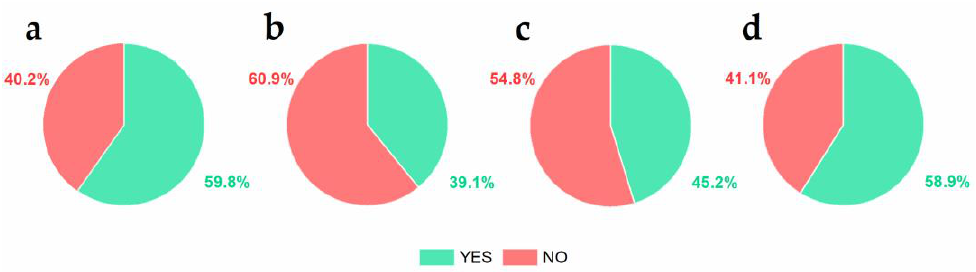
Figure 4. Share of people considering the environmental impact when selecting building materials in the surveyed groups: ( a ) investors, ( b ) architects, ( c ) contractors, ( d ) sellers of construction products.